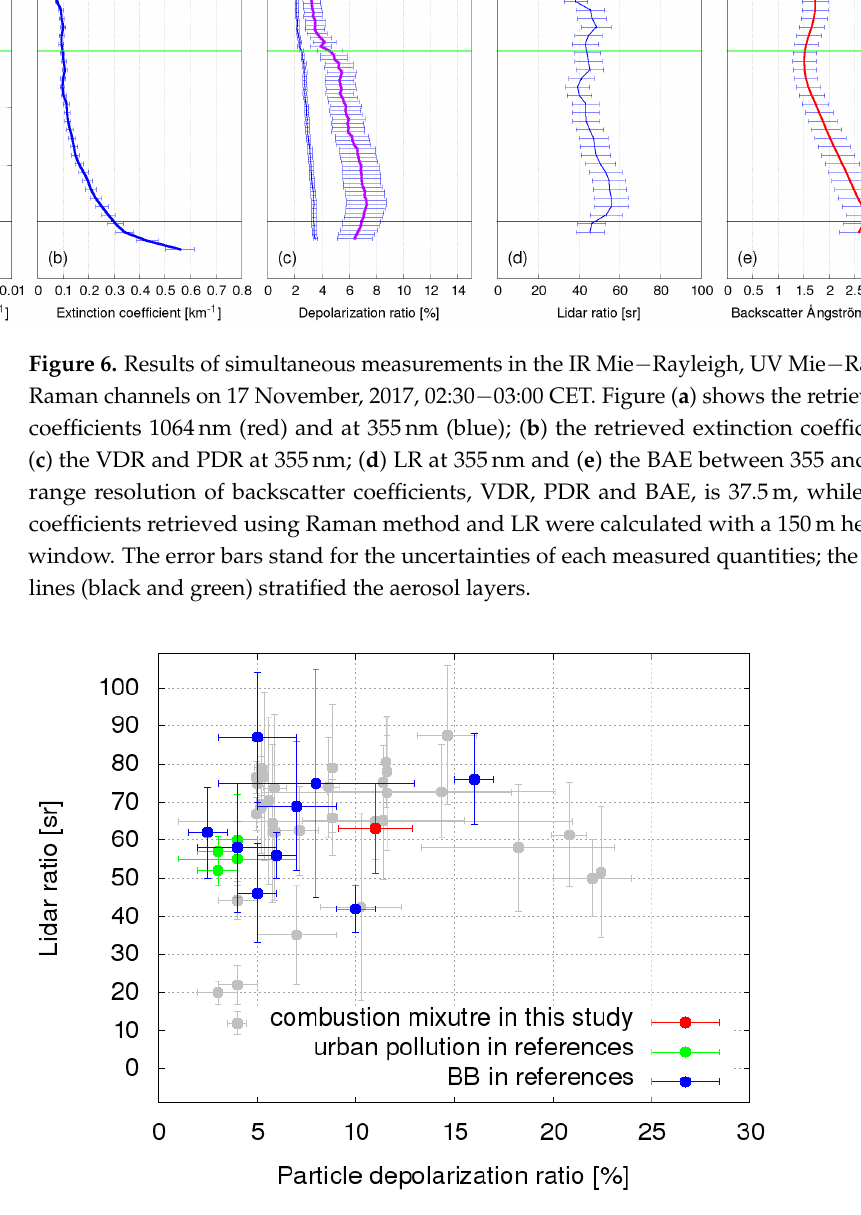
Figure 7. Distribution of LR and PDR values for 33 days with different atmospheric conditions and aerosol composition (grey). Data for Case (17 November 2017) is marked with red. LR and PDR values for biomass burning aerosols (blue) and urban pollution (green) were obtained from [18–20,54–56]. These were further categorized by the in situ aethalometer measurements of the AAE at Otlica, 841 m above the lidar site (Figure 8). AAE value of about 1.35